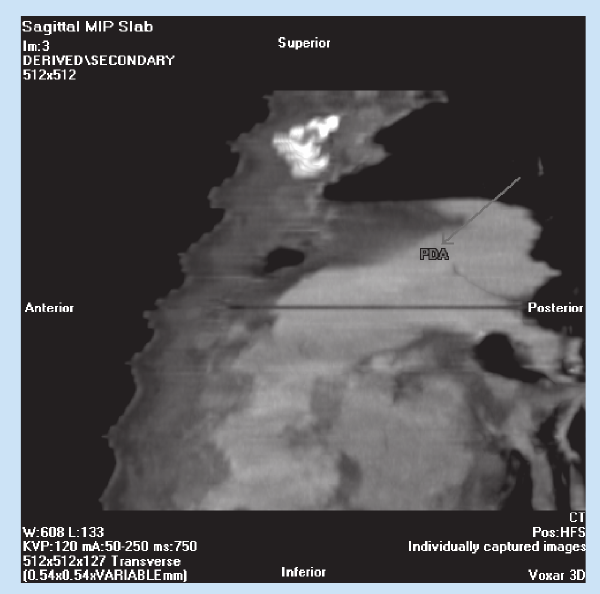
Fig. 2. Multislice spiral pulmonary angiogram: Sagittal maximum intensity projection; arrow points to PDA.